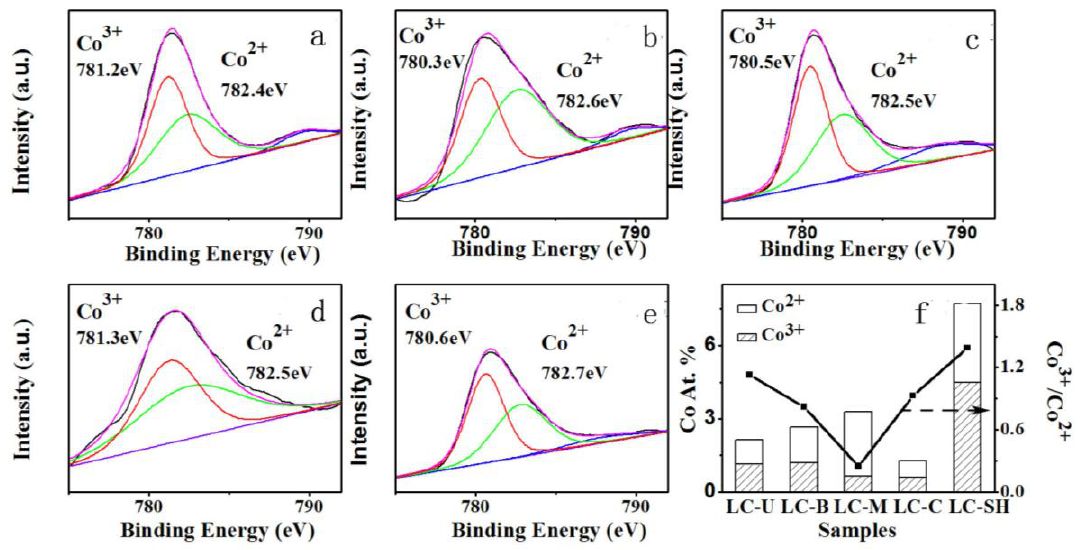
Figure 7. Co 2p X-ray photoelectron spectra (XPS) spectra of catalysts with different nitrogen sources. ( a ) LC-U; ( b ) LC-B; ( c ) LC-M; ( d ) LC-C; and, ( e ) LC-SH.